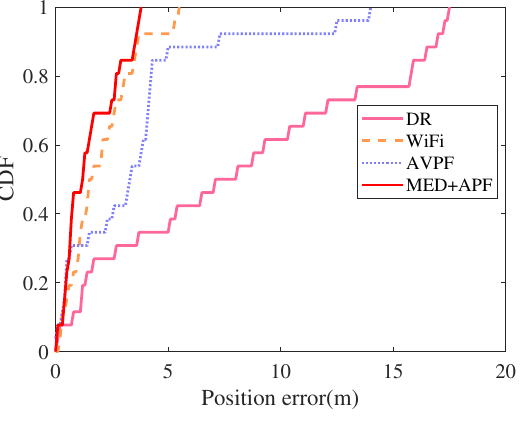
Figure 12. CDF of errors. Table 4. Position errors of DR, WiFi, PF, and MED+APF